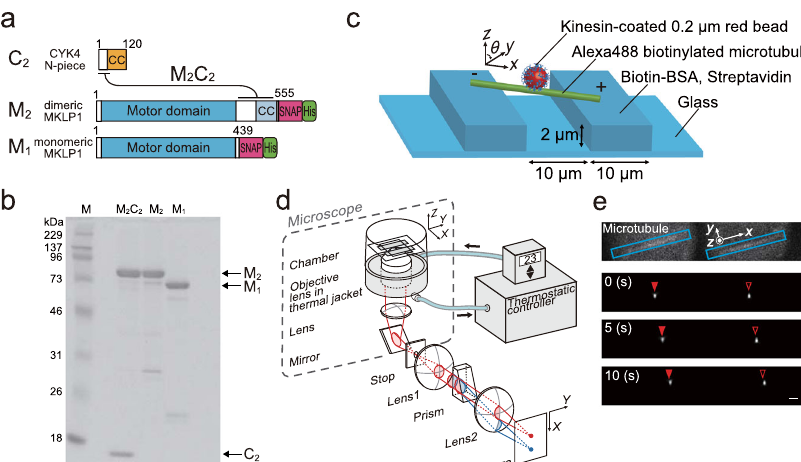
Fig. 1 3D tracking of MKLP1 kinesin-6 movement around the lattice surface of freely suspended microtubules. a A schematic of the domain structures of the dimeric N-terminal piece of CYK4 (C 2 , 1 – 120 a.a. of C. elegans CYK-4), dimeric MKLP1 kinesin-6 (M 2 , ZEN-4 (1 – 555 a.a.)-SNAP tag-His tag), monomeric MKLP1 (M 1 , ZEN-4 (1 – 439 a.a.)-SNAP tag-His tag), and M 2 C 2 (the complex of M 2 and C 2 ). CC: coiled coil. b SDS-PAGE analysis of the puri fi ed M 2 , M 2 C 2 and M 1 . Coomassie blue-stained SDS-polyacrylamide gel (12%). Lane 1: molecular size markers (in kDa), Lanes 2 – 4: puri fi ed M 2 C 2 , M 2 , and M 1 . The arrows indicate the positions of the individual proteins. c A schematic of the experimental setup. Glass was patterned into 2 µ m-high, 10 µ m-wide parallel walls with a 10 µ m gap. Microtubules were suspended between them using streptavidin-biotin interaction. This allowed beads coated with multiple kinesin molecules to move all around the microtubule surface. d A schematic drawing of a 3D prismatic optical tracking (termed tPOT ) microscope. The z position of kinesin-coated bead motion as well as the x – y position are obtained from a pair of images split by the prism. The temperature of the sample is maintained at 23 °C by the combined temperature management unit. e Pairs of split images by the tPOT microscope. The top panel shows a pair of split images of an Alexa488-biotin-labeled microtubule (marked by blue rectangles). The other panels show the time series of paired images of an M 2 -coated bead moving along the suspended microtubule (pairs of solid and open red arrowheads). (Scale bar, 1.5 µ m; 5 s interval between